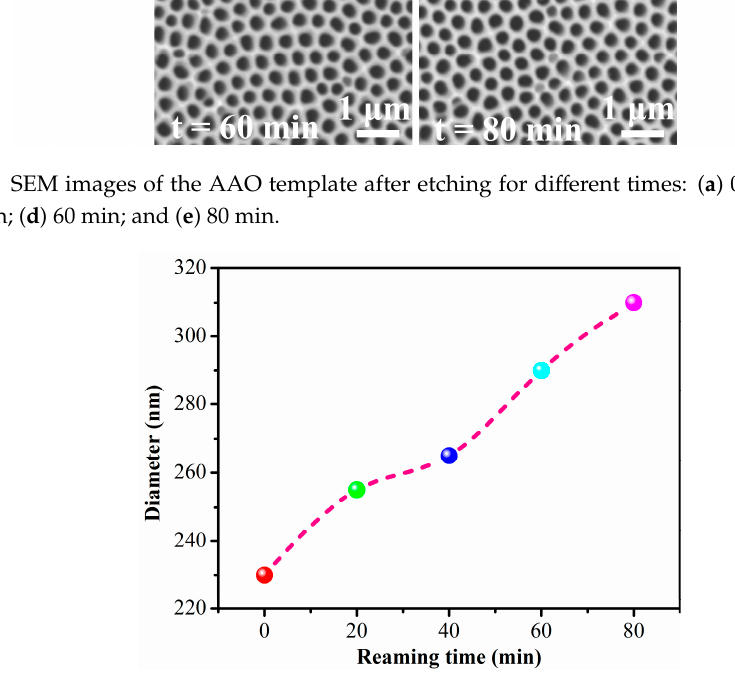
Figure 9. Curve correlating the mean pore diameter with etching time.